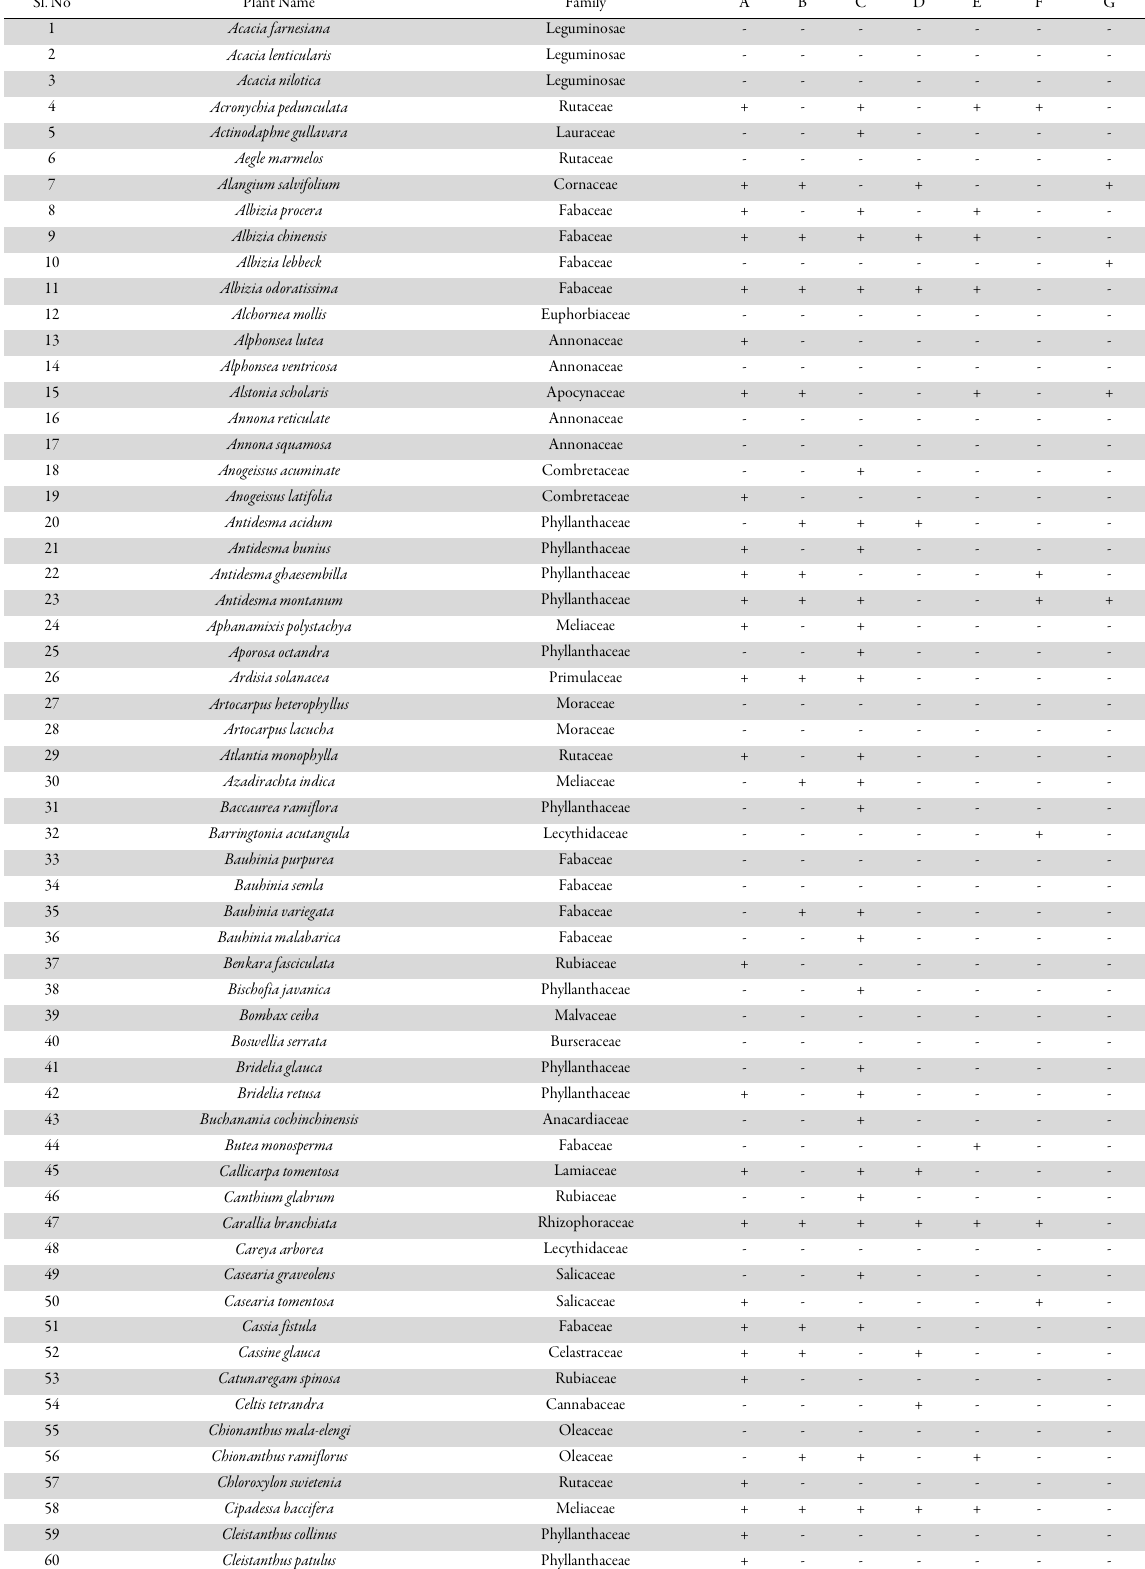
356 Table 1. List of 240 tree species of SBR and their affinity Sl.